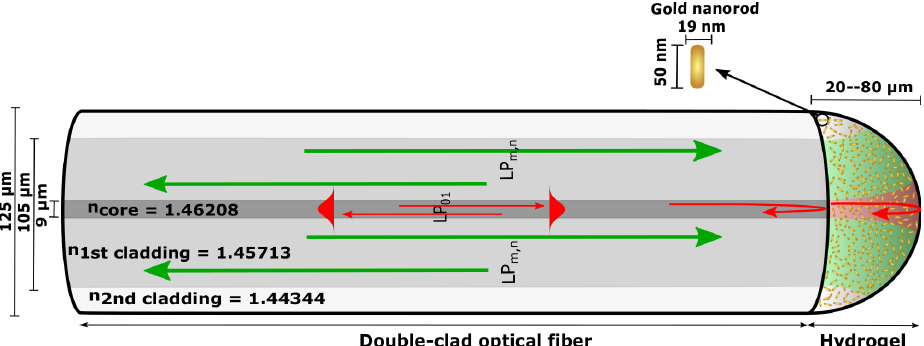
Figure 1. Illustration of the double-clad optical fiber combining interferometric and plasmonic sensor modalities with n core = 1.46208, n 1st cladding = 1.45713, and n 2nd cladding = 1.44344. Light in the range of 1500–1600 nm ( λ I ) is confined as single transverse mode both in the fiber and in the hydrogel volume, with reflection at the OF–hydrogel interface and hydrogel–solution interface illustrated with red color. Multi-mode with light in the range of 450–850 nm ( λ II ) is guided in the first cladding with numerical aperture illustrated with green on fiber-end face. The FP interference is measured with λ I , while the LSPR signal from gold nanorods (GNR) is measured with λ II